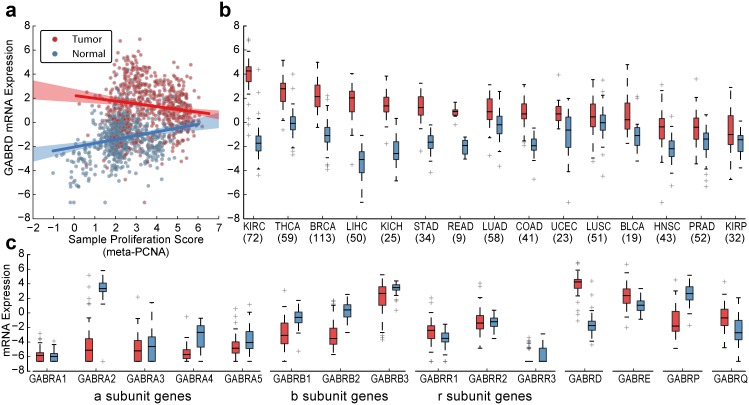
GABRD is tumor-associated, independent of proliferation.(a) Scatter-plot comparing GABRD gene expression profiles to proliferation scores across matched tumor and normal samples. Lines indicate linear regression figs of tumor (red) and normal (blue) samples, shaded regions indicate 95% confidence intervals. (b) Comparison of matched tumor and normal profiles for GABRD expression, grouped by tissue type. (c) Comparison of matched tumor and normal profiles for all GABA protein subunits in renal cell carcinoma. Cancer acronyms are defined as follows: KIRC, kidney renal clear cell carcinoma; THCA, thyroid carcinoma; BRCA, breast invasive carcinoma; LIHC, liver hepatocellular carcinoma; KICH, kidney chromophobe; STAD, stomach adenocarcinoma; READ, rectum adenocarcinoma; LUAD, lung adenocarcinoma; COAD, colon adenocarcinoma; UCEC, uterine corpus endometrioid carcinoma; LUSC, lung squamous cell carcinoma; BLCA, bladder urothelial carcinoma; HNSC, head and neck squamous cell carcinoma; PRAD, prostate adenocarcinoma; KIRP, kidney renal papillary cell carcinoma.